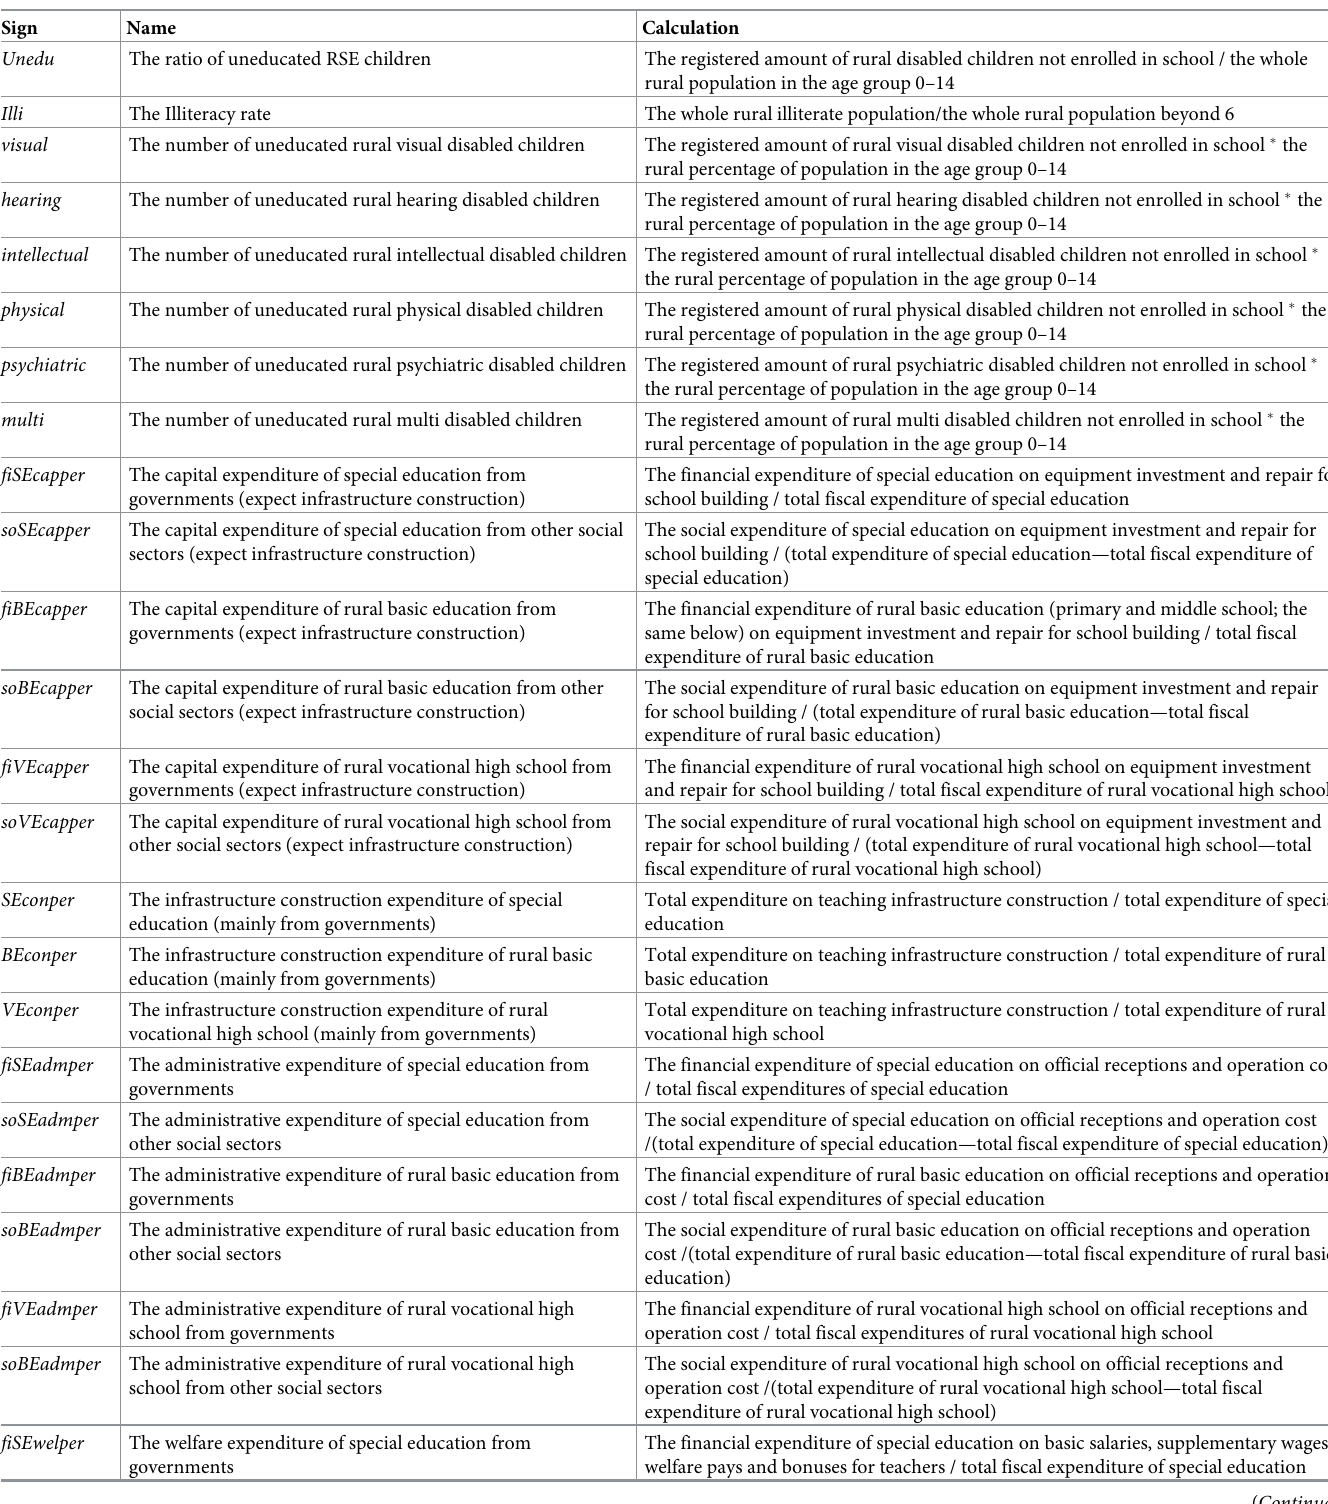
Table 1. The checklist of all